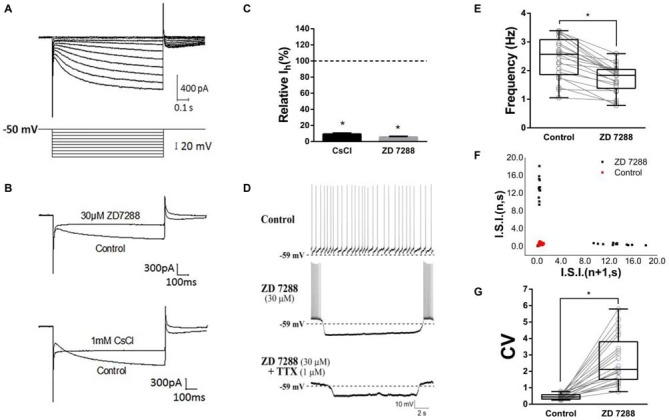
Contribution of HCN currents (Ih) to tonic firing. (A) The specific Ih was isolated in dorsolateral striatal ChIs. (B) Example traces of Current evoked at the −140 mV hyperpolarizing voltage before and after bath application of hyperpolarization-activated cyclic nucleotide-gated (HCN) channel blockers, ZD7288 (30 μM) or Cs+ (1 mM). (C) ZD7288 and CsCl significantly blocked the Ih. (D) ZD7288 (30 μM) induced a discontinuously hyperpolarized pause and altered the spiking pattern. The induced action potential bursts were block by TTX but not the subthreshold membrane potential oscillation. (E) ZD7288 significantly decreased the overall event frequency of spiking (*p < 0.001, paired student’s t-test, n = 21). (F) A representative scatter of joint consecutive interspike interval (I.S.I.) plot of the discharge. (G) ZD7288 significantly increased the coefficient of variation (CV) of the I.S.I frequency (*p < 0.001, paired student’s t-test, n = 21).